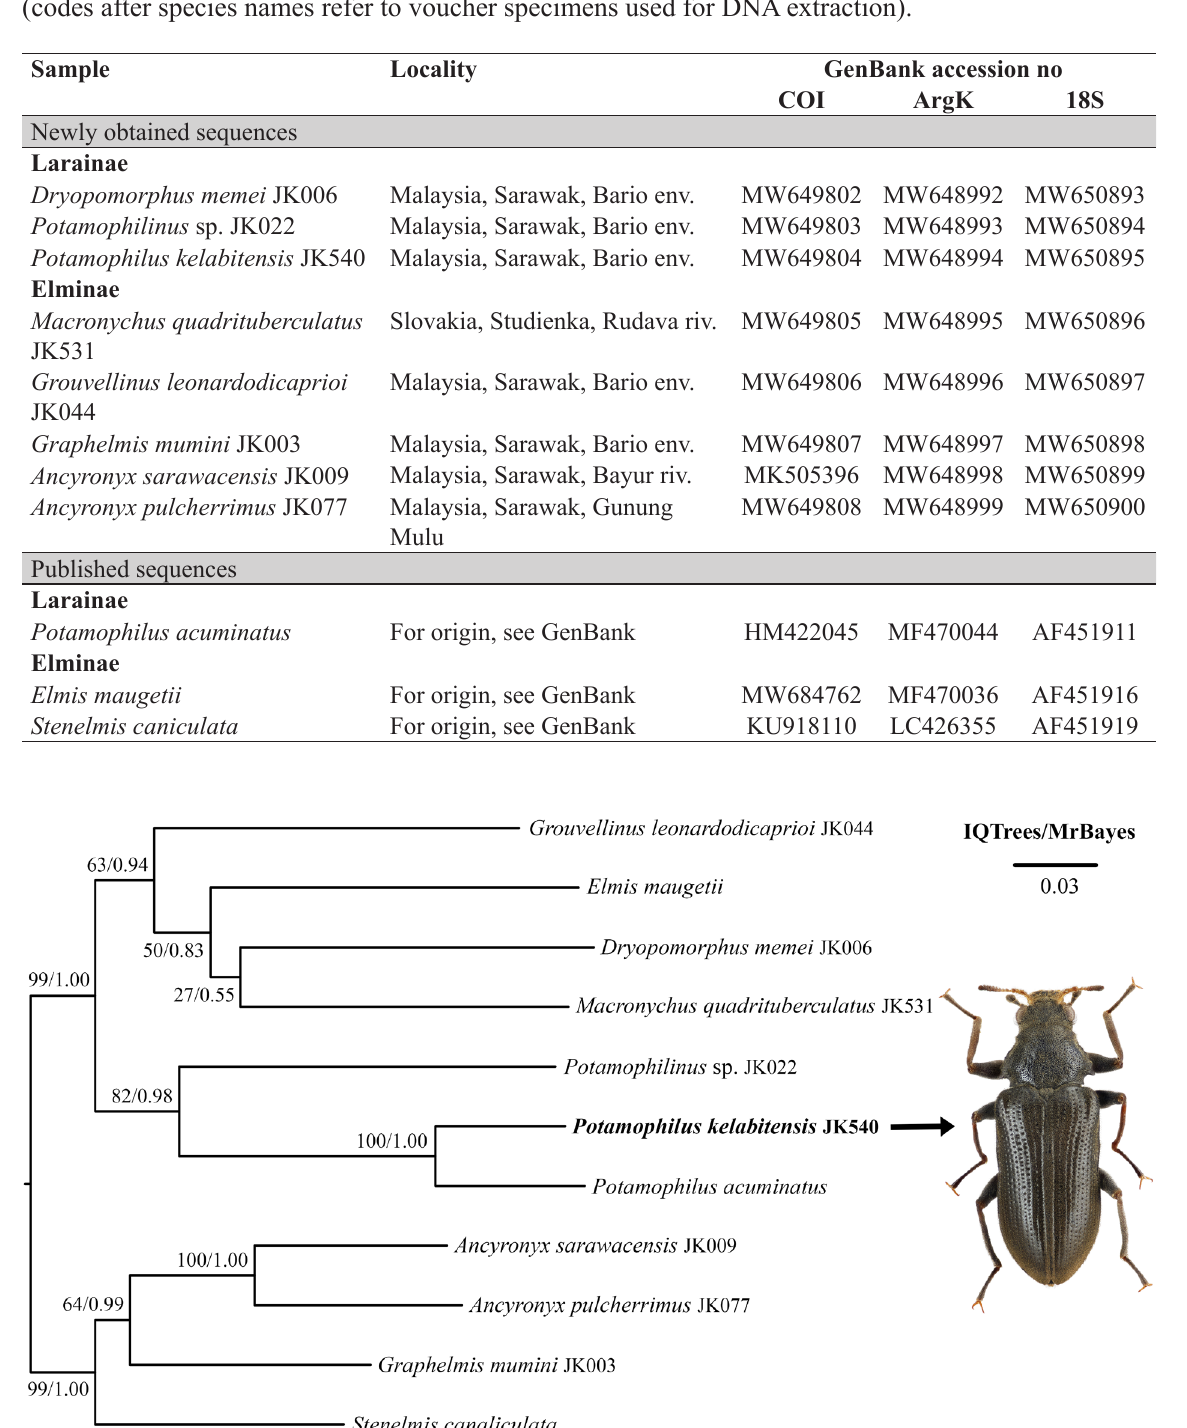
Table 1. Origin and GenBank accession numbers of molecular markers used in phylogenetic analyses (codes after species names refer to voucher specimens used for DNA extraction).